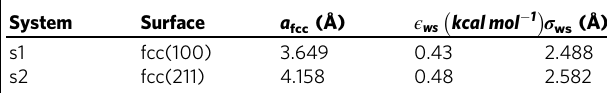
Table 2 Summary of simulation parameters such as the